Question: Produce a descriptive caption suitable for publication.
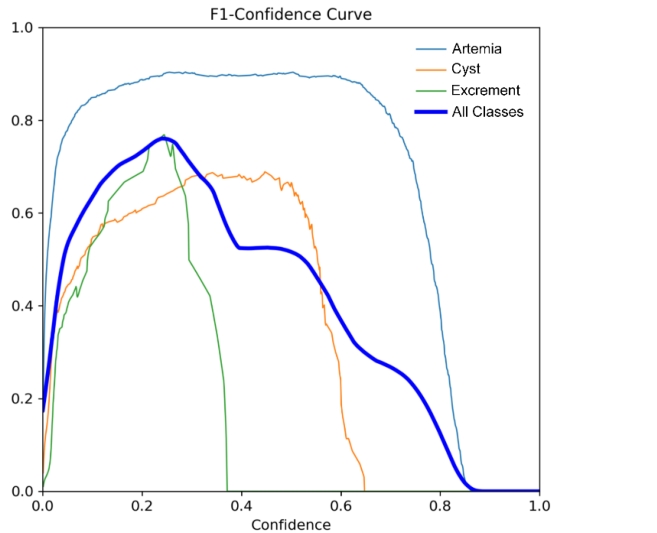
Answer: YOLOv5 F1 - Confidence curve